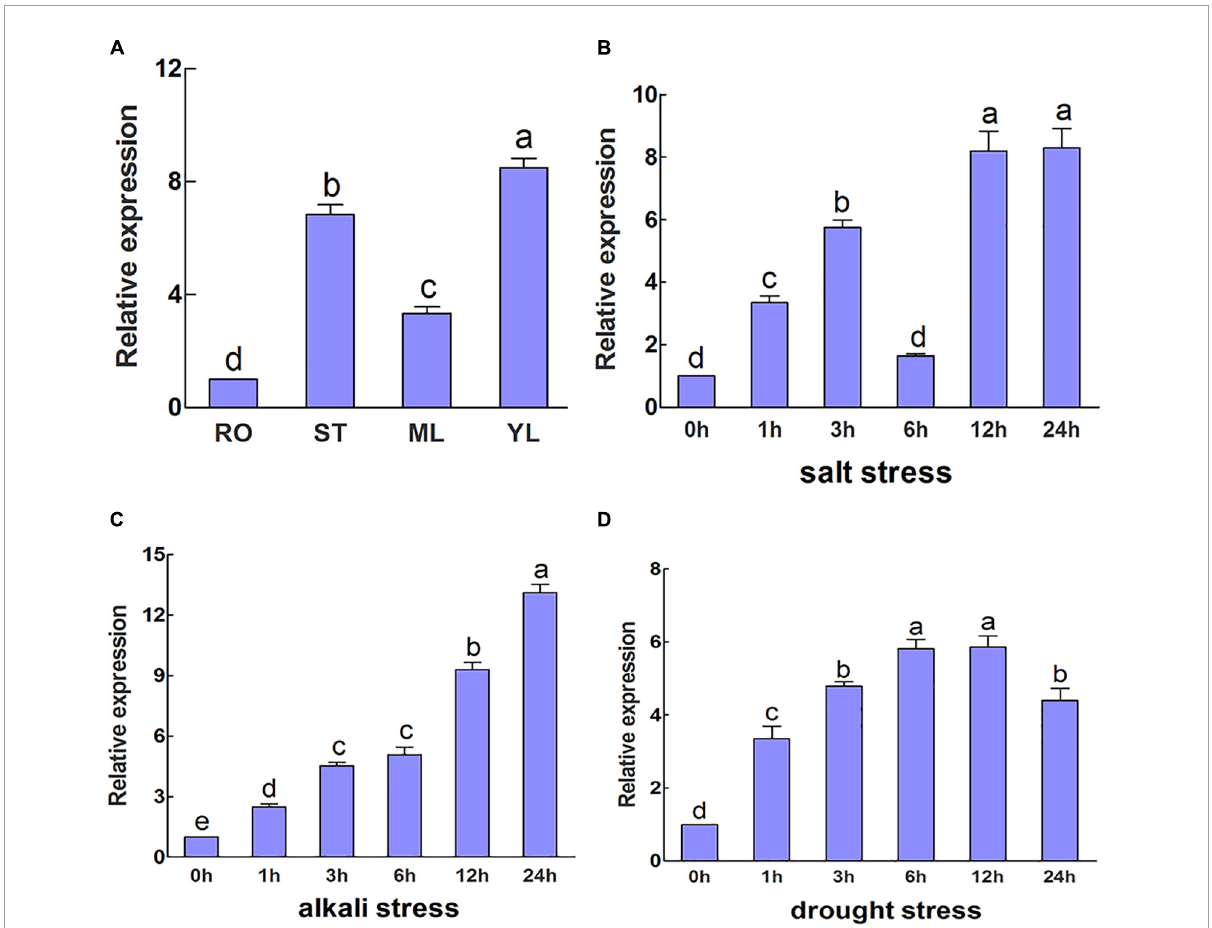
FIGURE2 The expression pattern of MsNF-YC2 in alfalfa. (A) Expression levels of MsNF-YC2 in different tissues. (B) Expression levels of MsNF-YC2 in response to salt treatment. (C) Expression levels of MsNF-YC2 in response to alkali treatment. (D) Expression levels of MsNF-YC2 in response to drought treatment. Each value is the mean ± SE of three biological replicates. Error bars represent the standard deviation of the mean. Significant differences by different letters above the bars at the P < 0 . 05 level according to Duncan’s multiple range